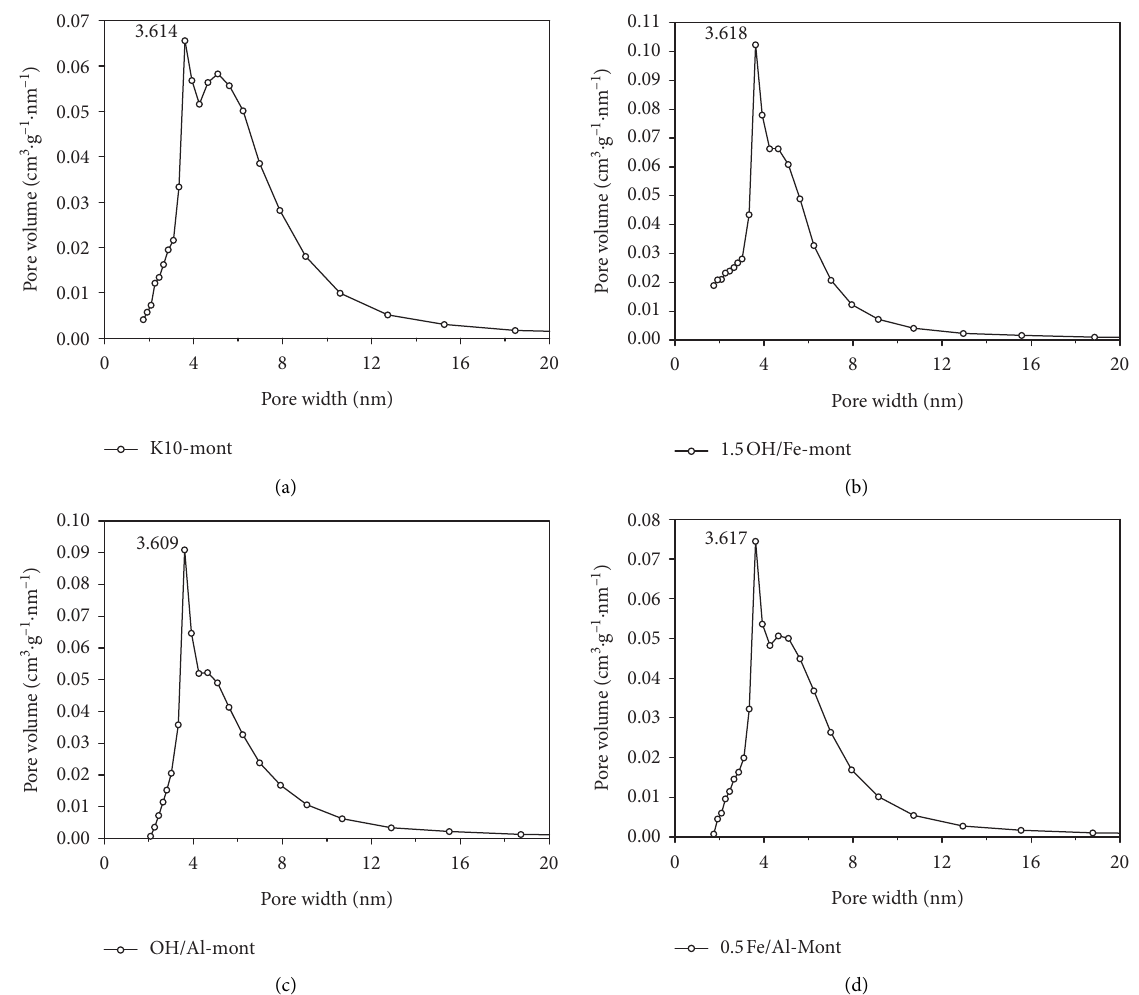
Figure 3: Pore volume distribution of hydroxyl-Fe-pillared